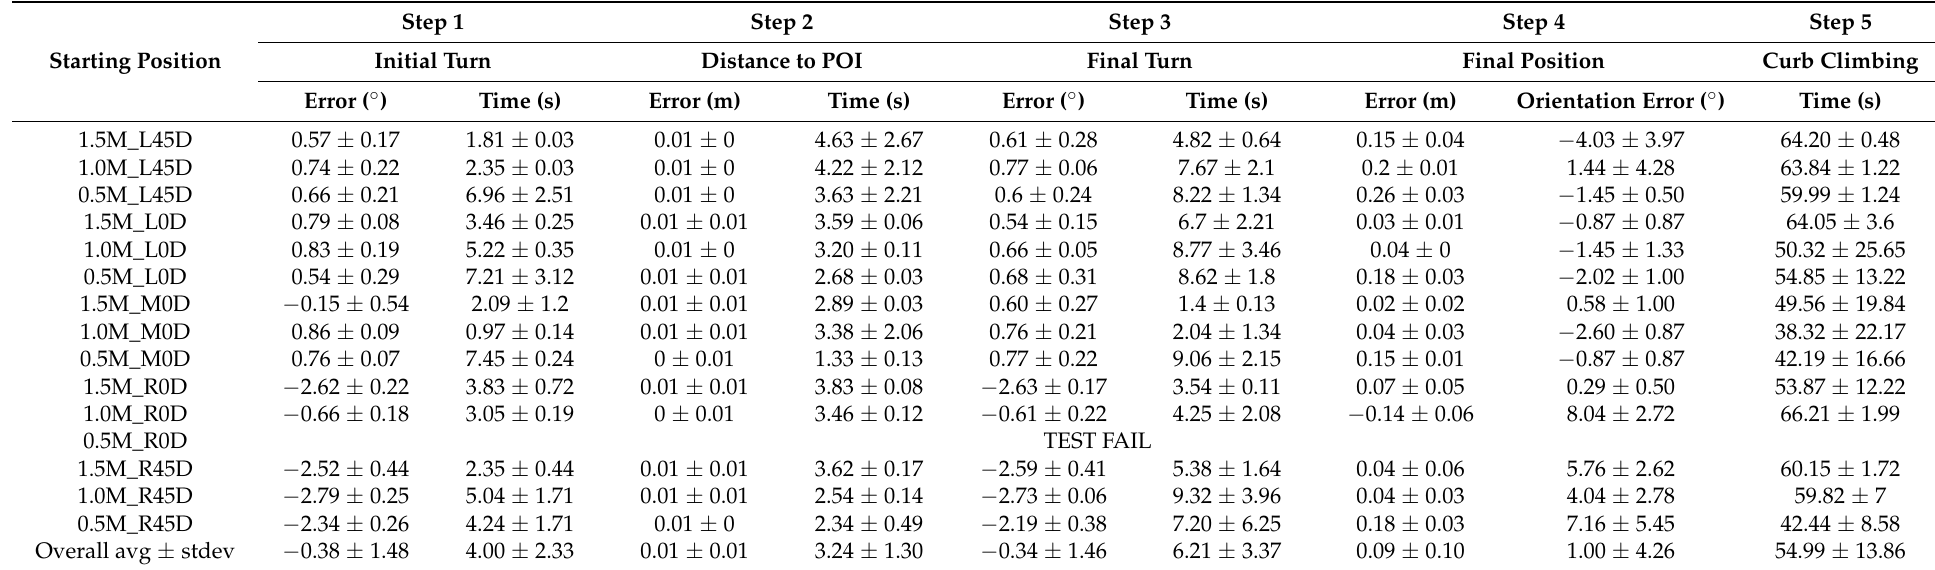
Table 1. Stepwise average maneuver error and time taken for 3 trials at each of the 15